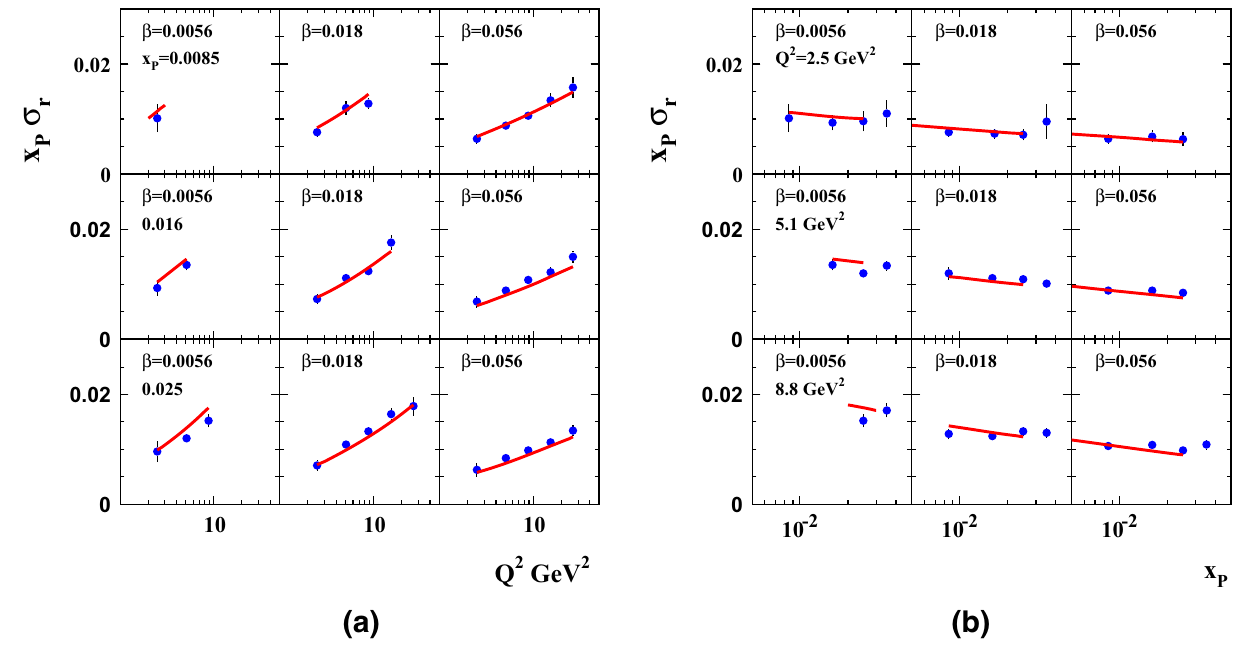
(cid:2) (cid:3) = x σ 2 at fixed β and x Y , Y 0 , Q 2 IP r versus Q